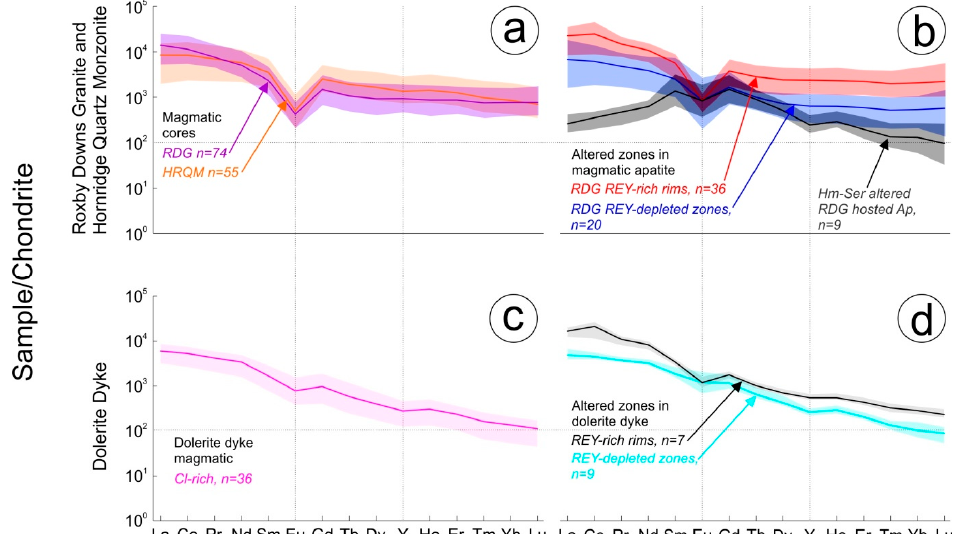
Figure 3. Chondrite-normalized [44] laser ablation inductively coupled plasma mass spectrometry (LA-ICP-MS) plots of apatite hosted in the igneous rock studied. Analyses were performed on multiple grains hosted within samples listed in captions for the respective tables. ( a ) Magmatic cores in RDG and HQRM apatite. ( b ) Hydrothermally altered zones in magmatic RDG hosted apatite. ( c ) Dolerite dyke magmatic apatite. ( d ) Hydrothermally altered zones in dolerite dyke magmatic apatite.